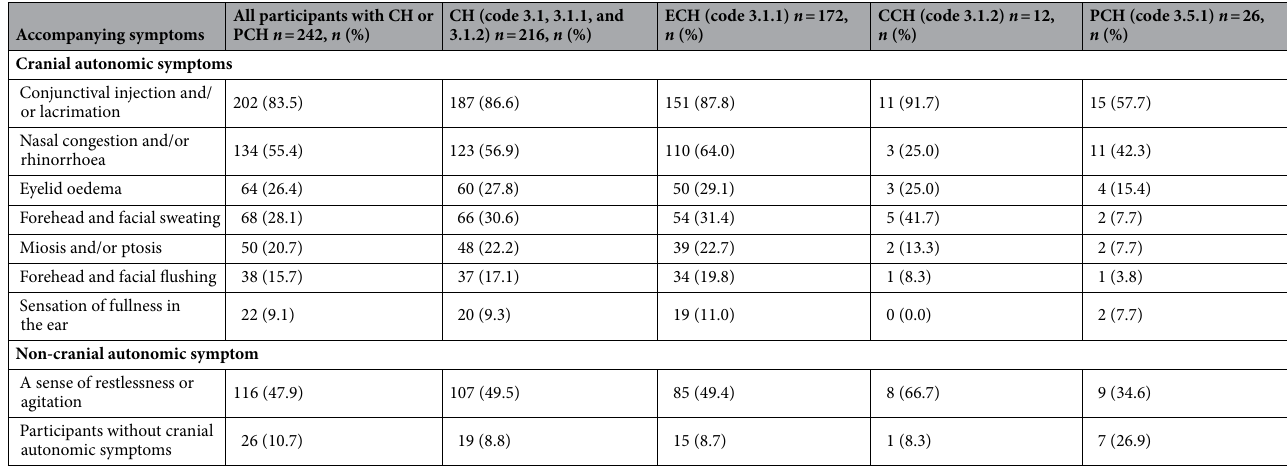
Table 1. Distribution of accompanying symptoms in the participants. CH cluster headache, PCH probable cluster headache, ECH episodic cluster headache, CCH chronic cluster headache.